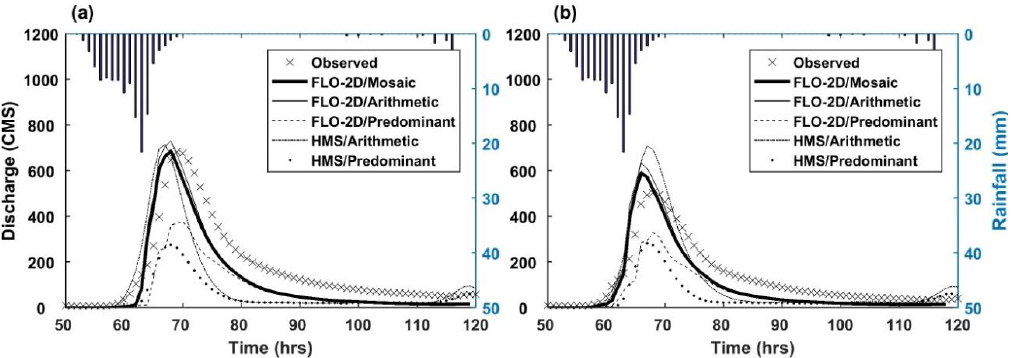
Figure 3. Observations compared to simulations of FLO-2D and hydrologic engineering center hydrologic modeling system (HEC-HMS), based on the curve number method: ( a ) Janghowon, ( b ) Cheonmi.